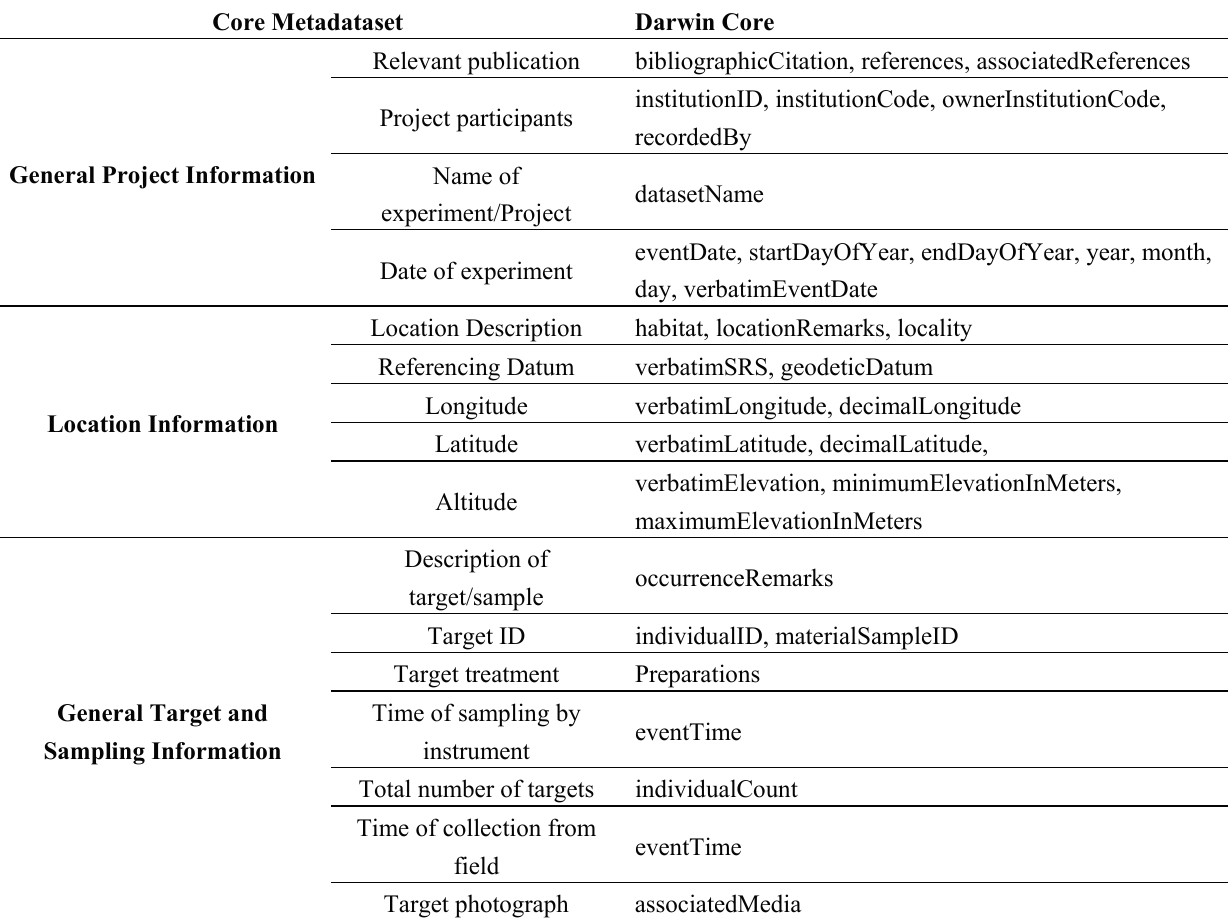
Table A3. Mappings from Darwin Core to the Core Metadataset.